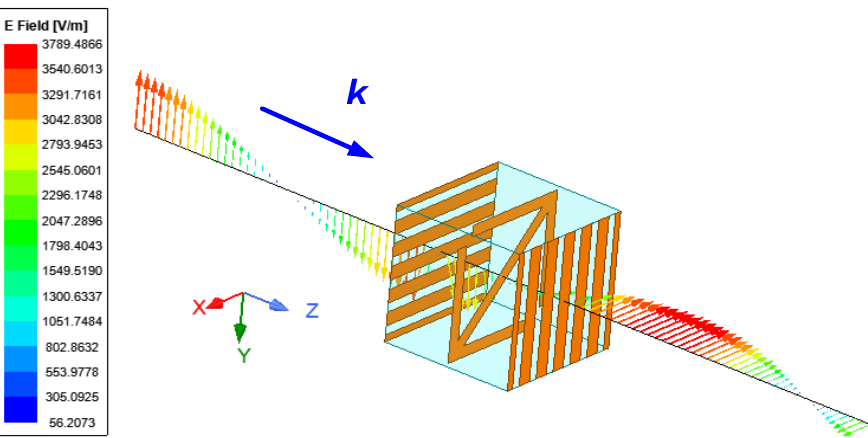
Figure 1. Structure diagram of metasurface element: ( a ) the element presented in this paper; ( b ) arrow-shaped metal patch.